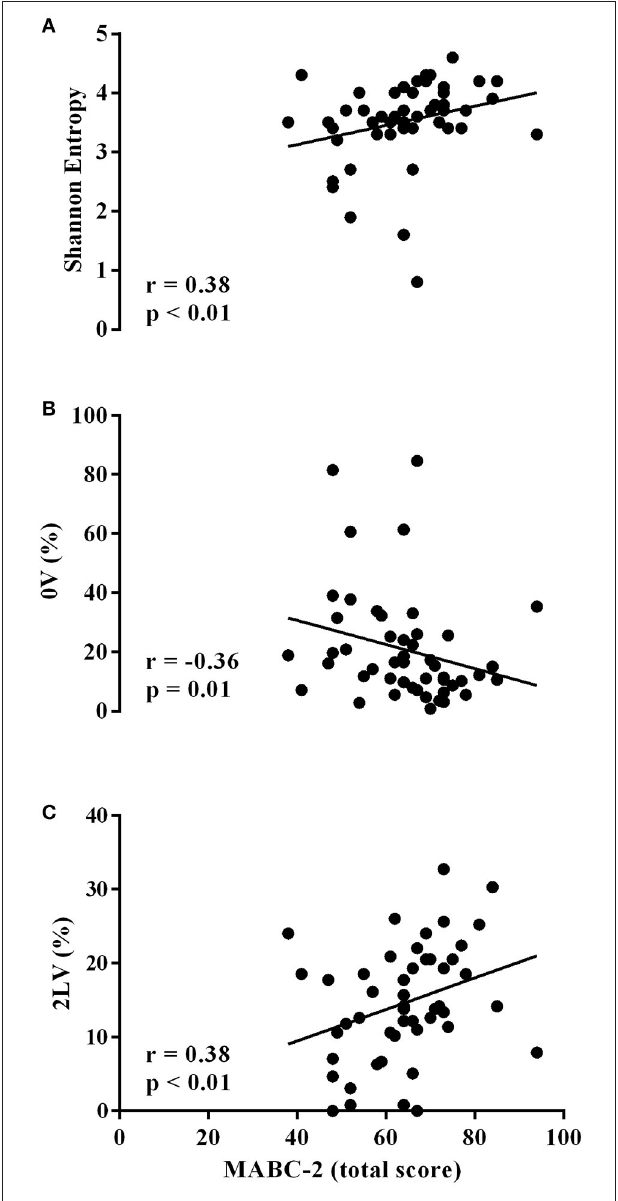
FIGURE 1 | Scatter plots of Shannon entropy (A) , 0V pattern (B) and 2LV pattern of symbolic analysis (C) at rest on MABC-2 total score are shown. Each solid circle is relevant to a pair (MABC-2, nonlinear heart rate variability indices) computed over a single individual.